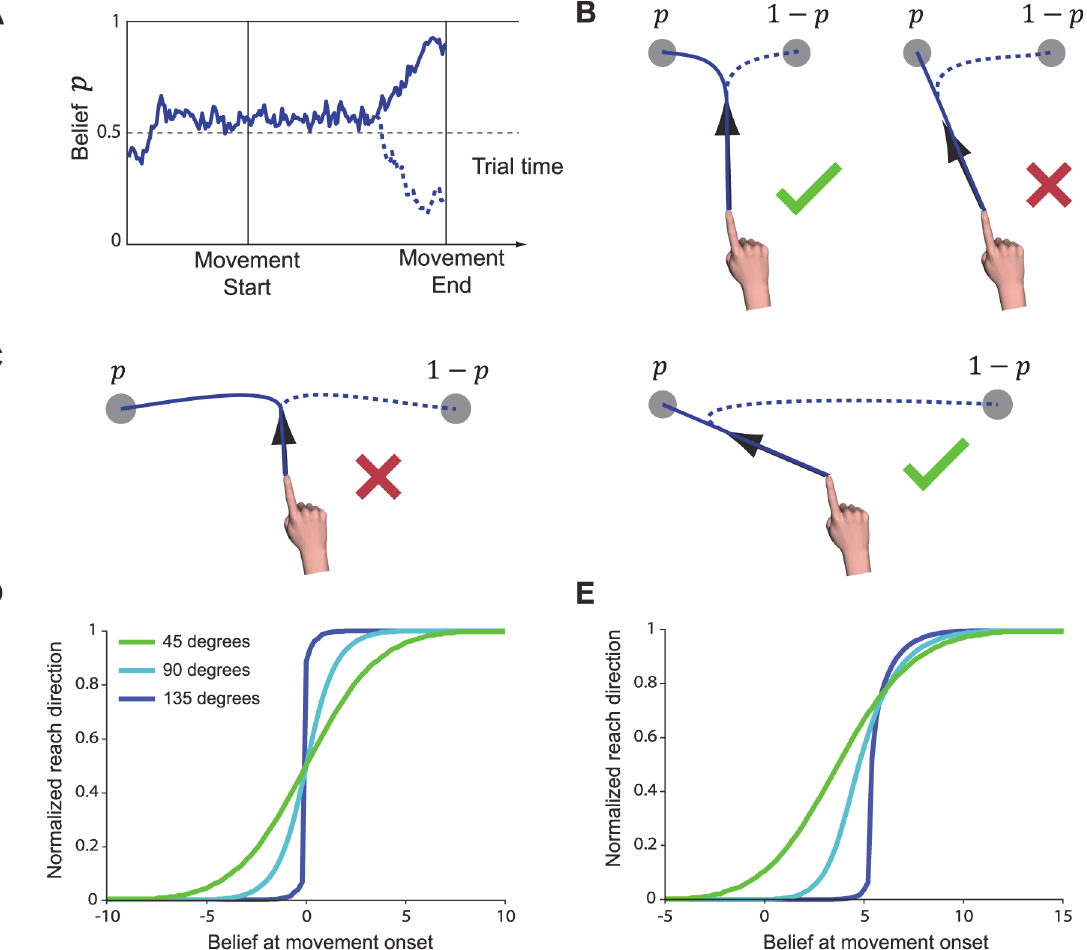
Fig 6. Computational model. A) Subjects are uncertain as to the true goal location among two possibilities and expect their beliefs to vary over time. In this case, the subject marginally favors the leftward target at movement onset ( p 0 > ½ ). During movement, this belief may either strengthen (solid line) or reverse (dashed line). B) When targets are nearby, the optimal course of action is to bias movement only slightly towards the more likely target, allowing greater flexibility later in the movement. C) When targets are widely separated, an intermediate movement is less advantageous. Instead, the optimal course of action is to commit to the more likely target from the outset. D) Predicted initial reach direction (normalized so that 0 corresponds to initial target, and 1 corresponds to the post-jump target) is plotted for a variety of target separations as a function of the initial belief state r 0 . E) As D), but for a model that uses an asymmetric cost function (see